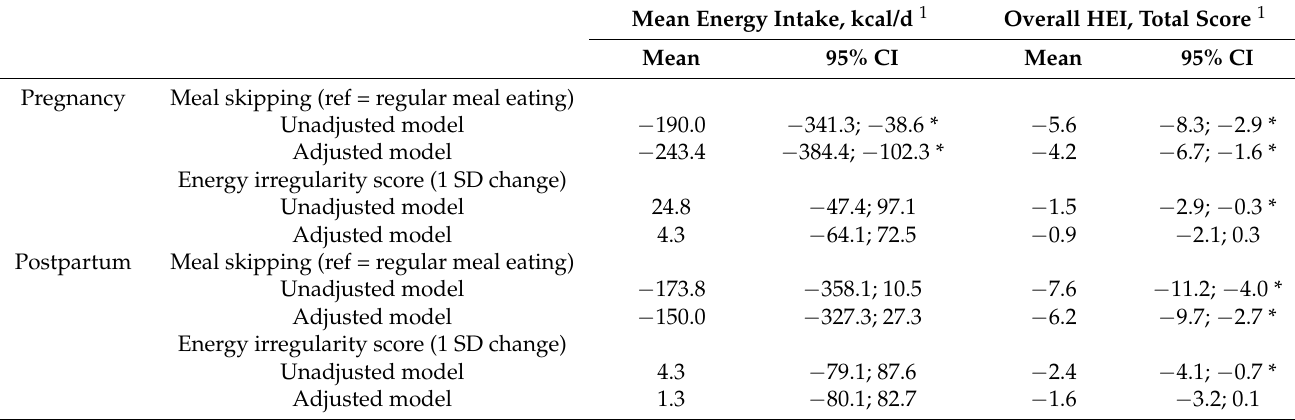
Table 3. Associations of eating regularity with mean energy intake and overall